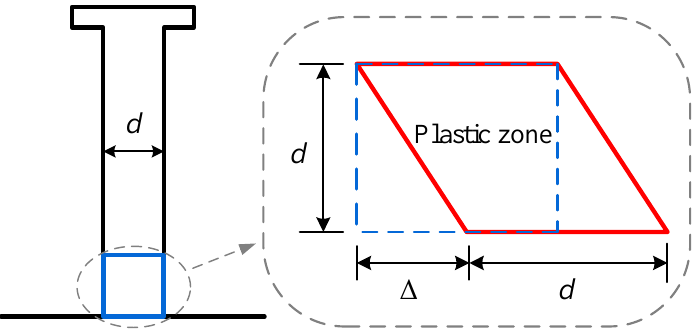
Figure 4. The plastic zone of the stud at its root.